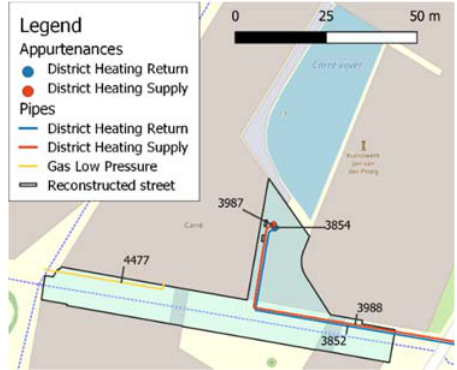
Figure 6. QGIS visualization of the components in